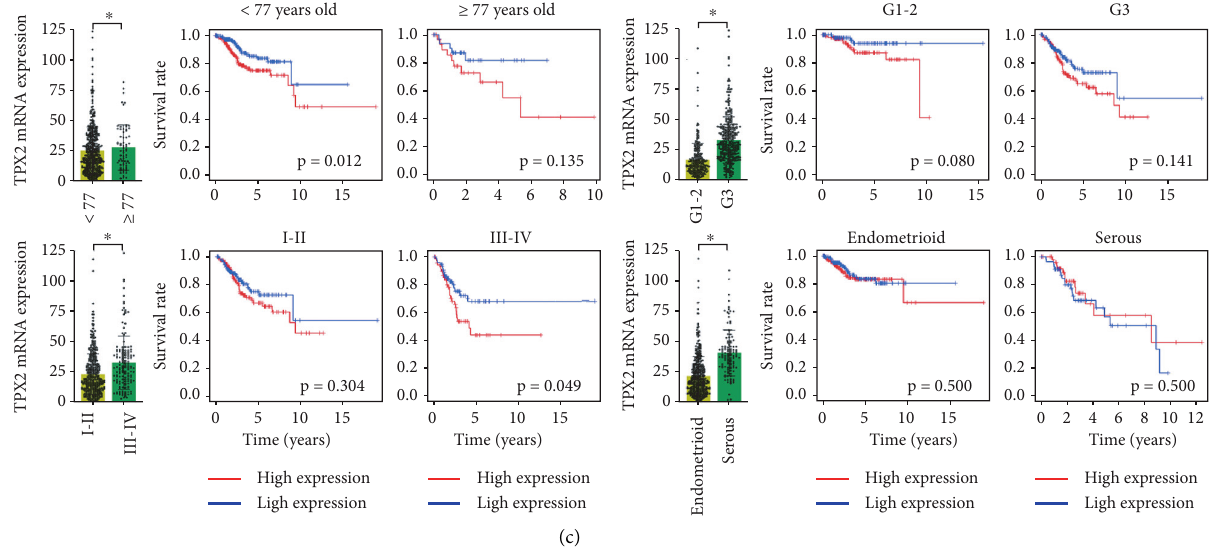
Figure 3: Determination of the tissue distribution of TPX2. (a) IHC images showing the cellular localization of TPX2 in cancerous and adjacent tissue sections from EC patients. Scale bar: 200 μ m, 100x magnification (A); scale bar: 50 μ m, 400x magnification (B). (b) Comparison of TPX2 distribution between cancerous and adjacent tissues. (c) The mRNA expression and effect of TPX2 on OS in EC patients stratified by age, tumor grade, FIGO stage, and histological type. ∗ p < 0 . 05 indicates significant subgroup difference based on the unpaired student’s